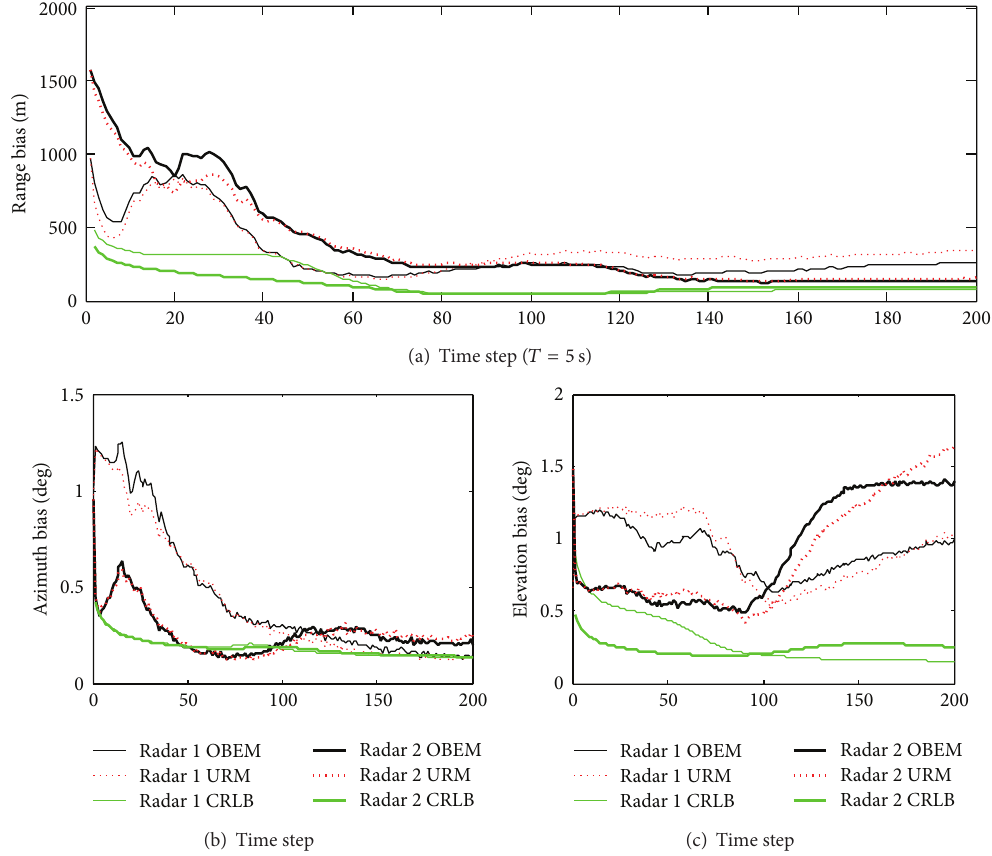
Figure 6: Root mean square errors (RMSEs) of radar gross BEs. (a) Range bias; (b) azimuth bias; (c) elevation